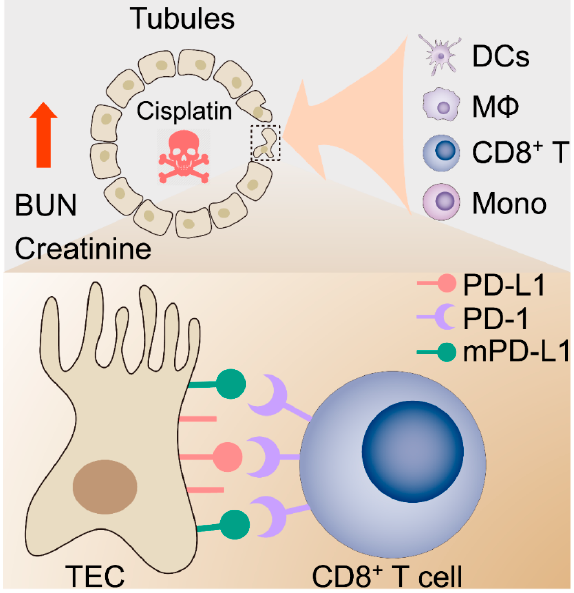
Figure 6. Proposed hypothetical model for the contribution of the kidney immune microenvironment and the PD-1/PD-L1 in nephrotoxic AKI.